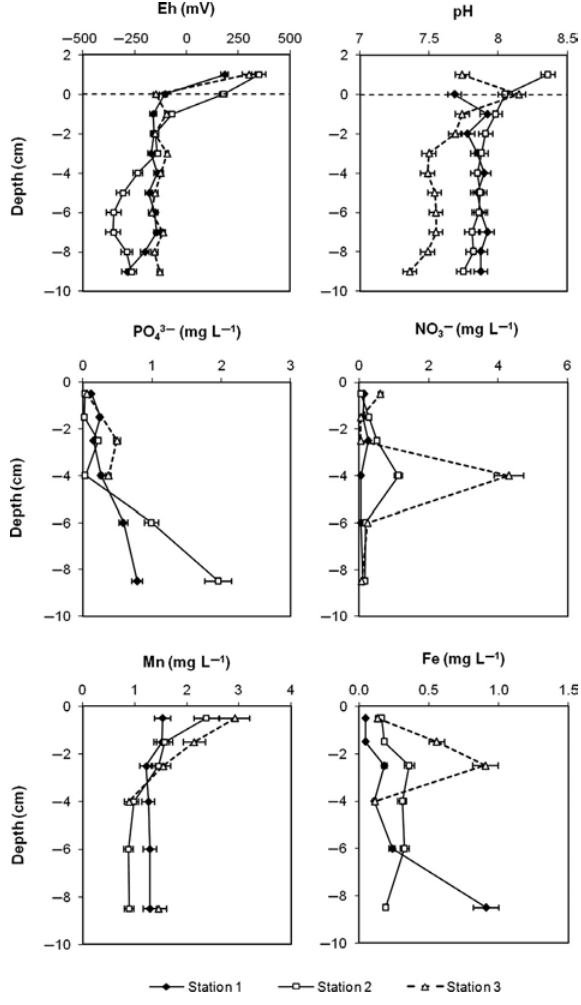
Fig. 3. Depth profiles of Eh (in mV vs. Ag/AgCl), pH and concentrations (in mg L (cid:29) 1 ) of nitrate, phosphate, iron and manganese in the dissolved phase of sedimentary pore waters (sampling stations 1, 2 and 3). Negative values in the y -axis correspond to depths in the sediment